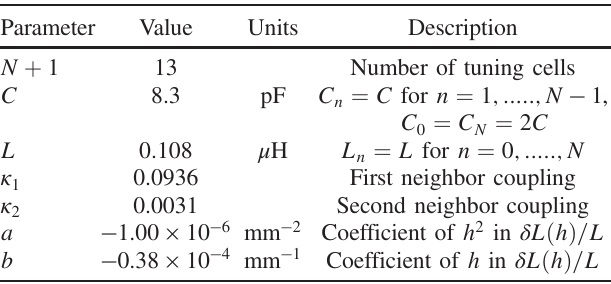
TABLE I. Lumped circuit model